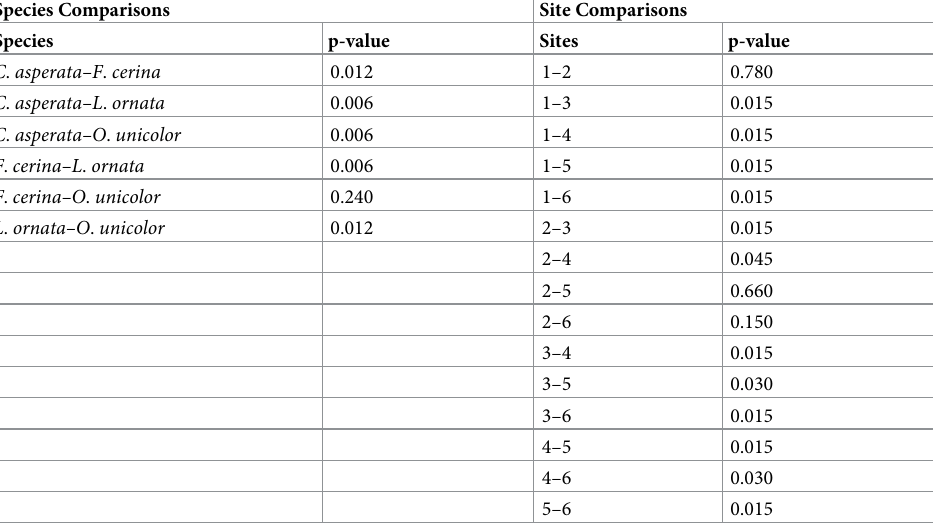
Table 1. Pairwise species and site comparisons for gut microbiomes of freshwater mussels collected from six sites in the Sipsey River, AL, USA. Microbiome comparisons were based on the Bray-Curtis dissimilarity metric. Mussel species are Cyclonaias asperata , Fusconaia cerina , Lampsilis ornata , and Obovaria unicolor and the six sites cover a ~50 km stretch of the river, numbered from upstream to downstream. P-values come from a PERMANOVA comparing bacterial community composition by host mussel species and by site. The test excluded seston samples which were sig- nificantly different from each mussel species at each site (p < 0.01 for all). The R package pairwiseAdonis was used to perform a post-hoc test to determine which pairwise combinations of species and site were significant. Adjusted p-val- ues of this post-hoc test are displayed below. Species